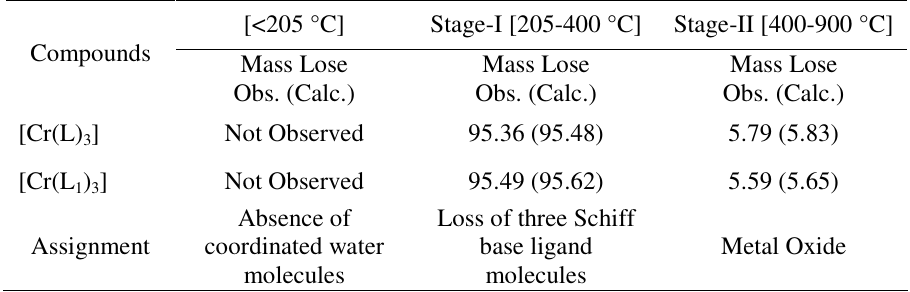
Table 6. Thermo analytical results of Cr(III) complexes of Schiff base ligand L and ligand L